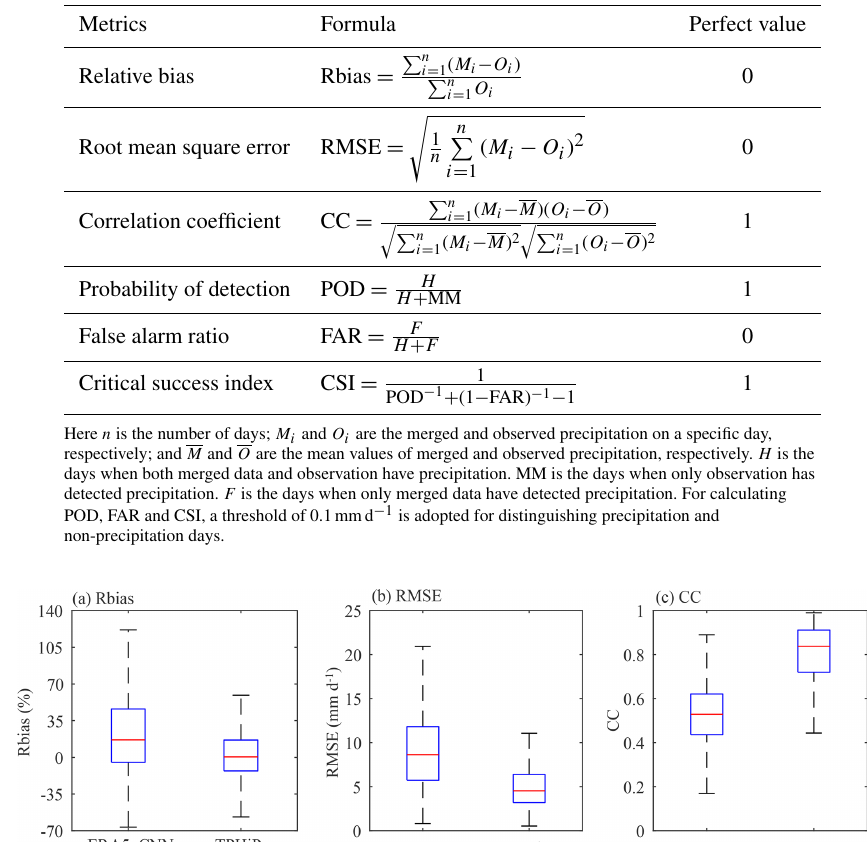
Table 1. The error metrics used in this study.